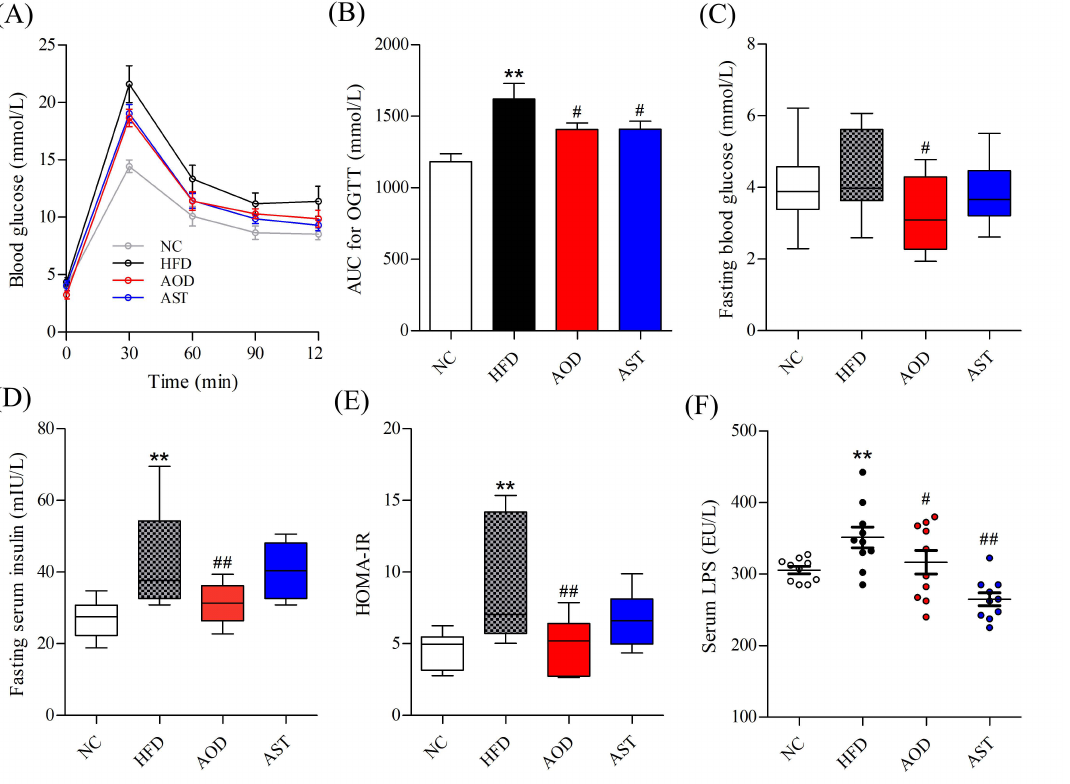
Figure 2. AOD ameliorated glucose intolerance and insulin resistance. ( A ) Blood glucose levels during oral glucose tolerance test (OGTT) at week 8. ( B ) Blood glucose area under the curve (AUC) for OGTT. ( C ) Fasting blood glucose level. ( D ) Fasting serum insulin level. ( E ) homeostasis model assessment